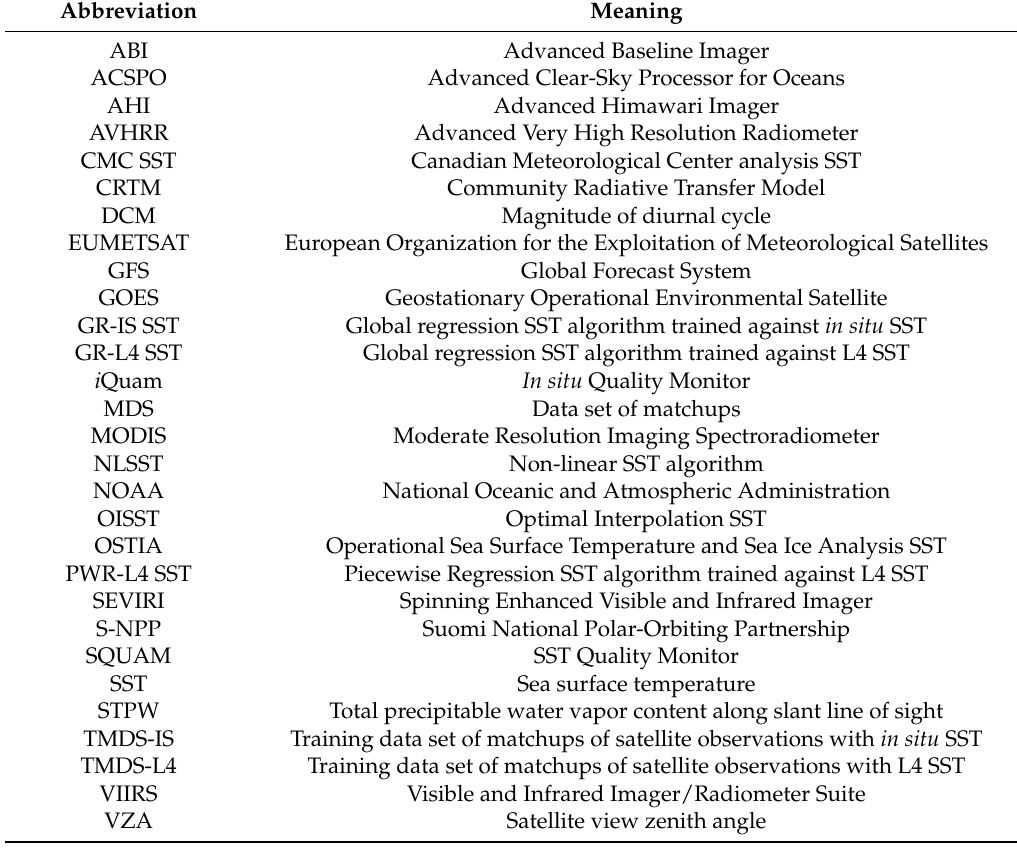
Table 1. The list of